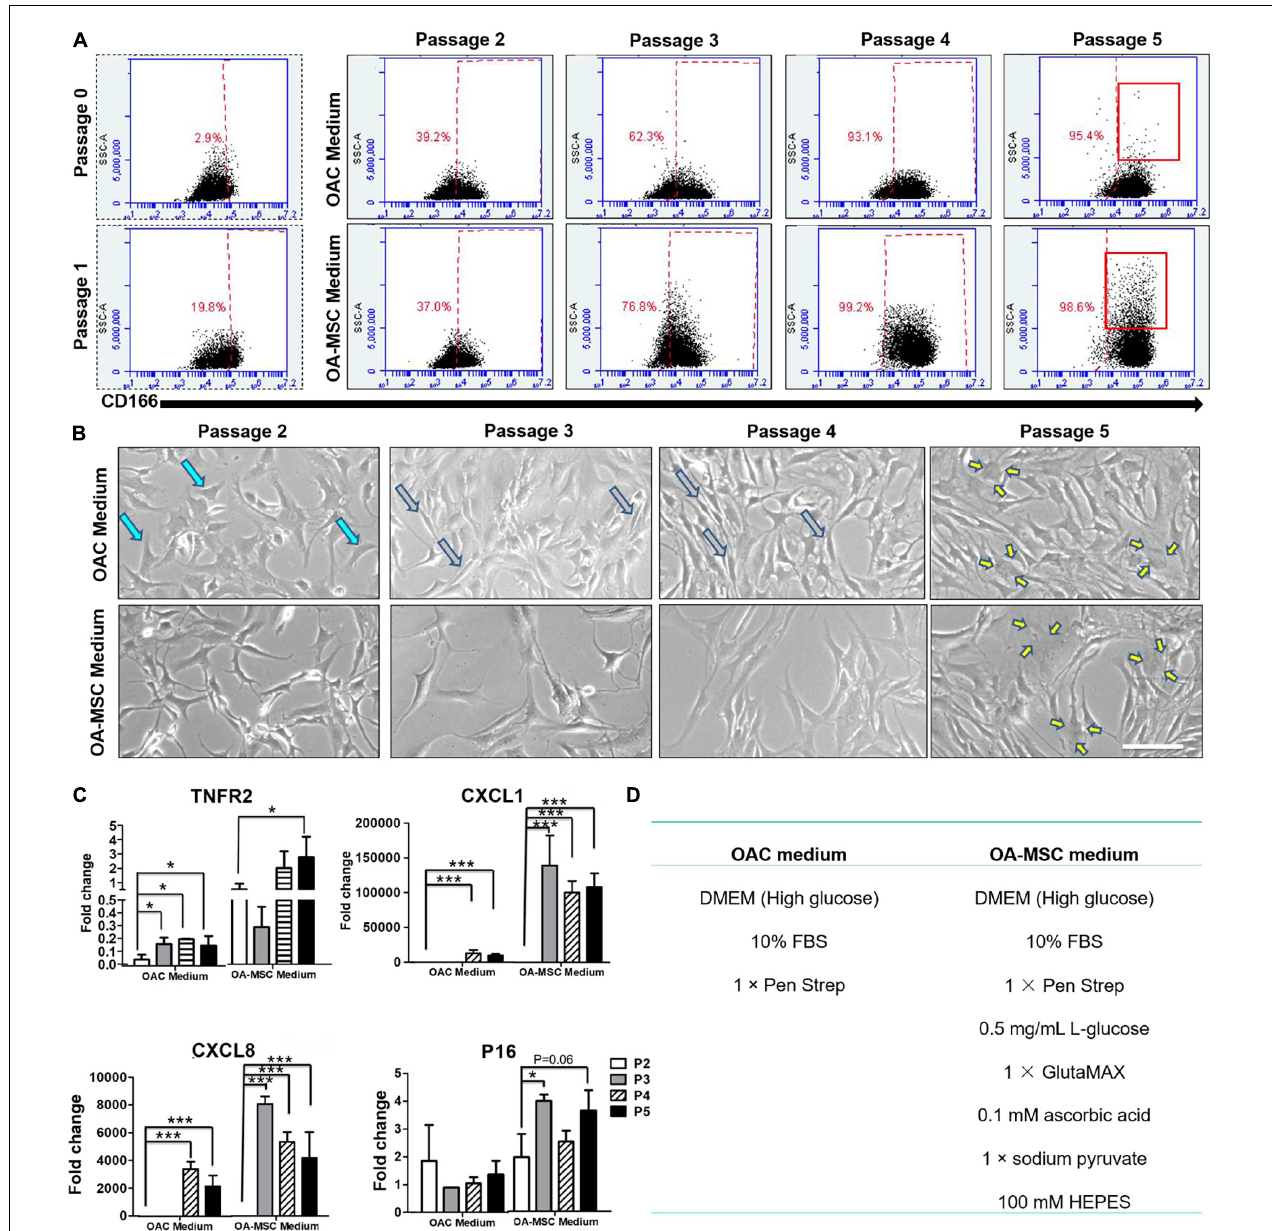
FIGURE 5 | Serial cell culture passage of OAC induces dedifferentiation into NCSC-like cells and subsequent senescence into pro-inflammatory OA-MSC. (A) FACS analysis of CD166 positive cells during OA chondrocyte passaging in OA-MSC culture medium or OAC medium. The percentage of CD166 positive cells in each passage ( x -axis) was indicated in red. The increase of the number of large sized cells ( y -axis), a characteristic of senescent cells, was indicated by brackets in Passage 5. The data is representative of three experiments. (B) Cell morphology change of OA chondrocytes during cell culture passages in OAC medium and OA-MSC culture medium. OAC changed its morphology from cuboidal shape typical of chondrocytes (aquamarine arrows) in early passages (2 and 3) to spindle shape typical of fibroblasts (gray arrows) in mid passage (4) to large cells with processes typical of senescent cells (yellow arrows) in late passage (5). Bar = 200 µ m. (C) Expression of aging related genes during OAC culture passages in OAC medium and OA-MSC medium. mRNA levels of TNFR2, CXCL1, CXCL8, P16 were quantified by real-time RT-PCR. The value of each sample group = mean ± SD. N = 3 for all groups. * p -value < 0.05; *** p -value < 0.001. (D) The components of OAC medium and OA-MSC